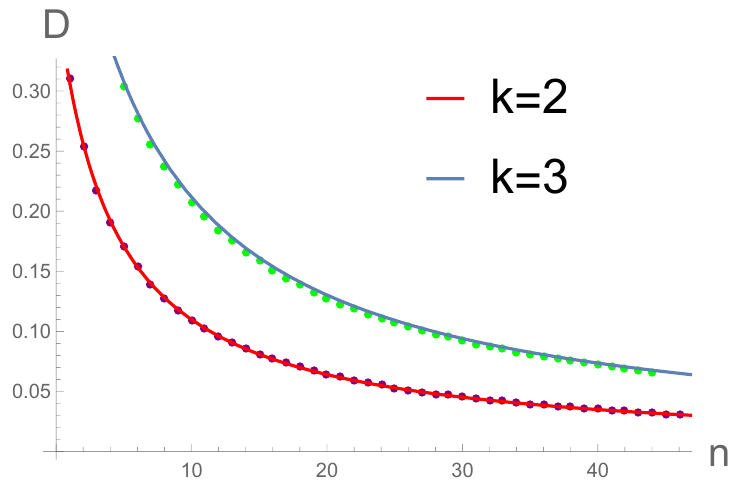
Figure 4 . Displaying the left-hand side of eq. (4.17) for k = 2 and k = 3 for W n as a function of n; as well as the best (cid:12)t curves of the form D = B we found B (cid:25) 3 : 385